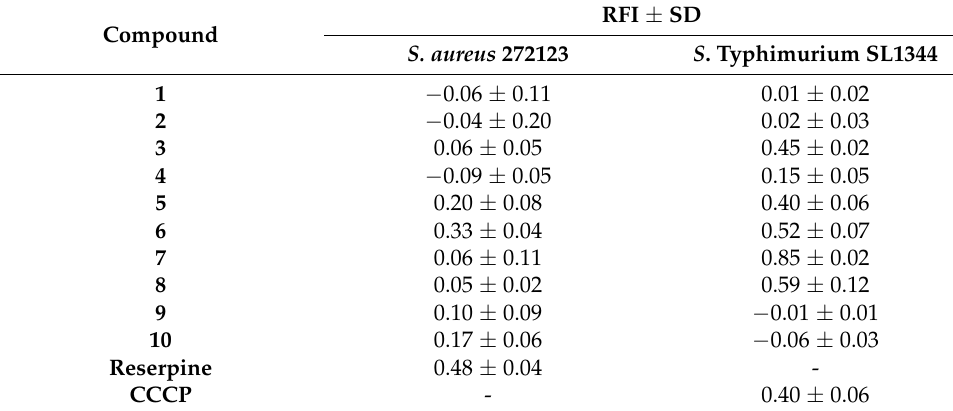
Table 2. Relative fluorescence index of chalcone derivatives 1–10